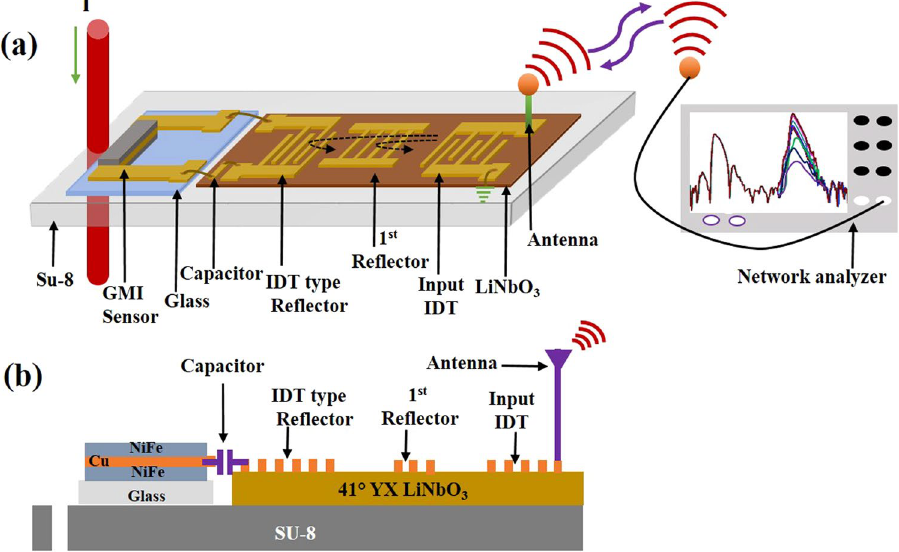
Figure 1. ( a ) Overall view of the developed chipless, wireless current sensor system. It consists of GMI sensor, one-port SAW delay line, impedance matching element, clip-on packaging platform, antenna, and reader system. ( b ) Cross-sectional view of sensor system on the clip-on packaging